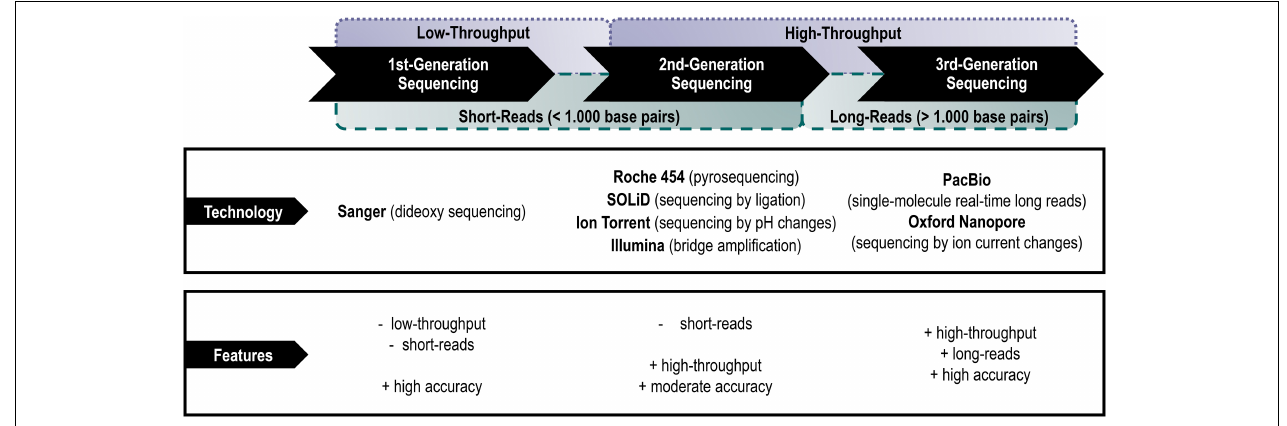
FIGURE 1 | Main representatives of the different generations of sequencing platforms with their main advantages and